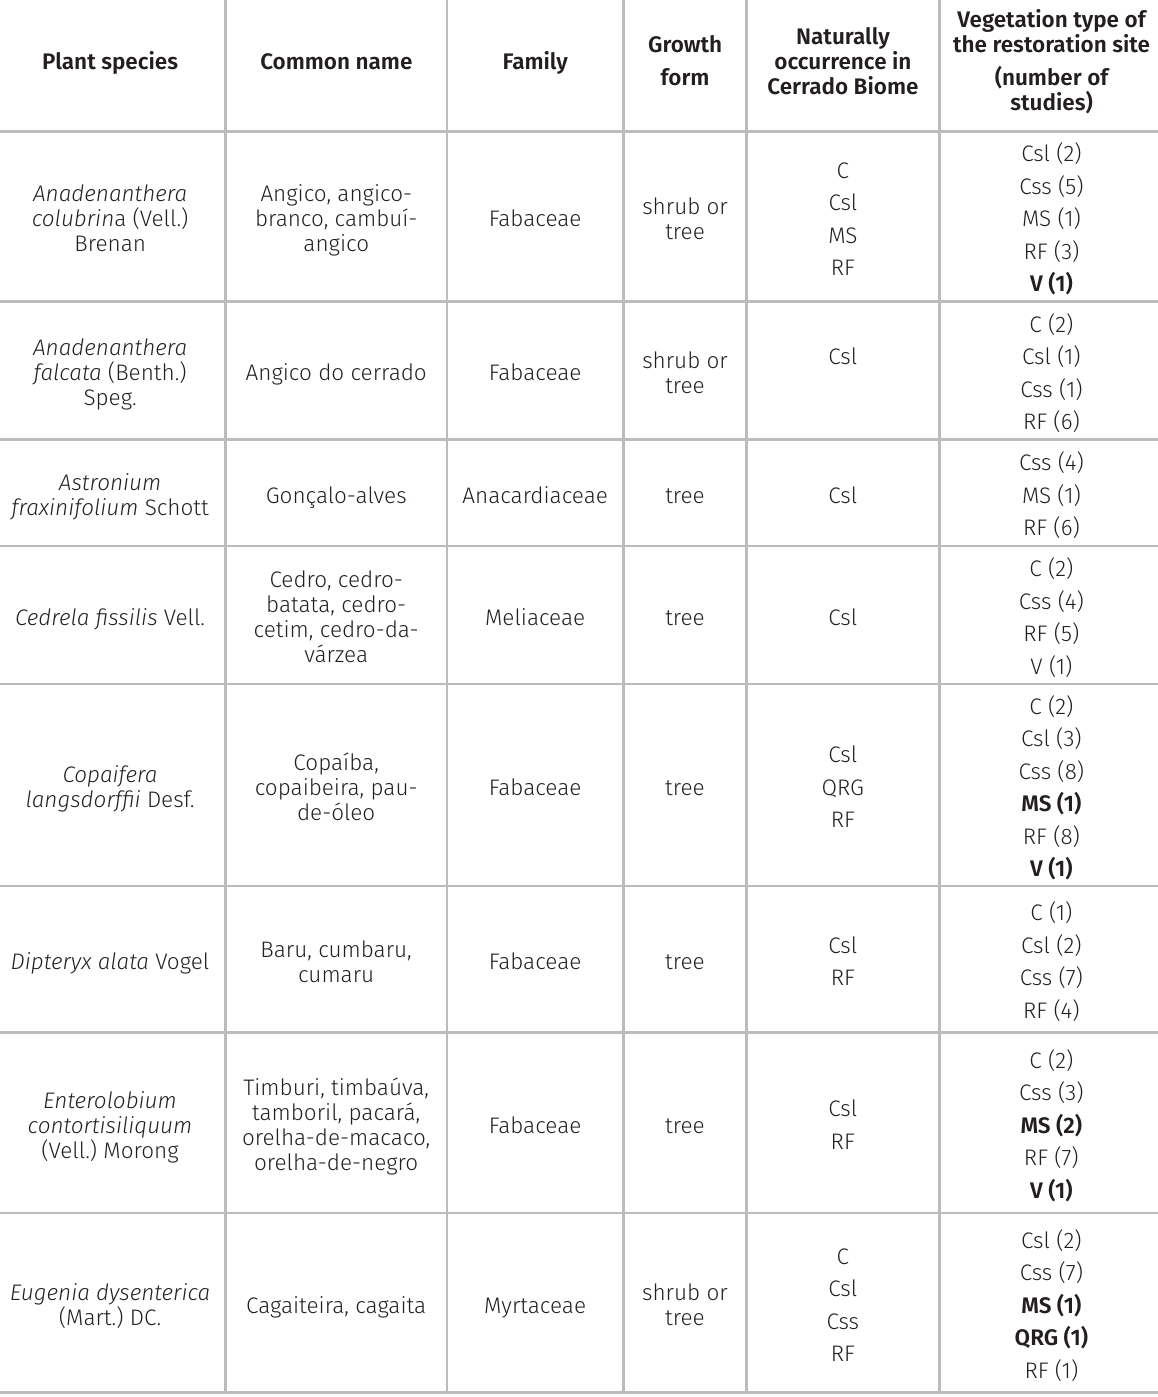
Table VII. The plant species most used in ecological restoration research of the Cerrado vegetation types. The Cerrado vegetation types are CL ( campo limpo ), C ( cerradão ), Csl ( cerrado sensu lato ), Css ( cerrado sensu stricto ), MS ( mata seca ), QRG (quartzitic rupestrian grassland), RF (riparian forest) and V ( vereda